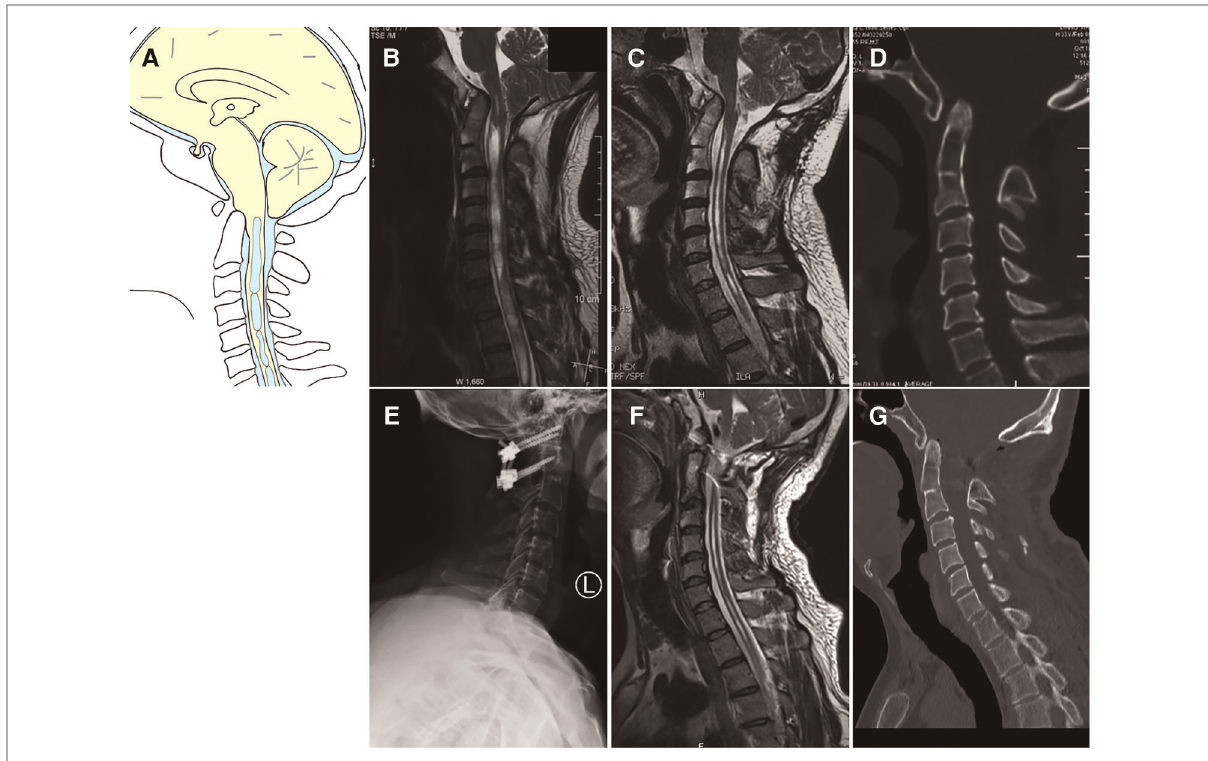
FIGURE 3 Case presentation of Group II, a 33-year-old man with dizzineess who received initial suboccipital decompression without fusion 6 months ago. The symptoms had worsened gradually. ( A ) Schematic drawings of the foramen magnum, sagittal view. ( B ) Preoperative MRI (sagittal view) showed ventral compression of the cervicomedullary junction, Chiari malformation and syringomyelia. ( C ) Preoperative MRI scan showed syringomyelia was reduced. ( D ) Preoperative CT scan showed basilar invagination, atlantoaxial dislocation and occipital bone defect. ( E ) Postoperative X showed C1 lateral mass screw and C2 pedicle screw fi xation. ( F ) Postoperative MRI showed good decompression of the cervicomedullary junction. ( G ) Postoperative CT indicated complete reduction of both basilar invagination and atlantoaxial